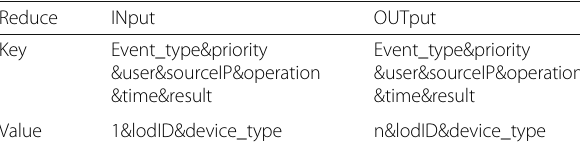
Table 2 Manage the Reduce phase input output for the configuration class log